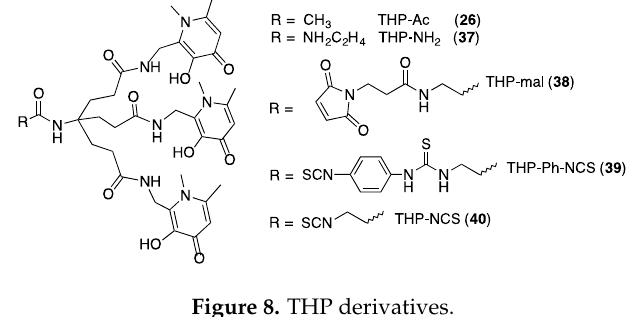
Figure 8. THP derivatives.